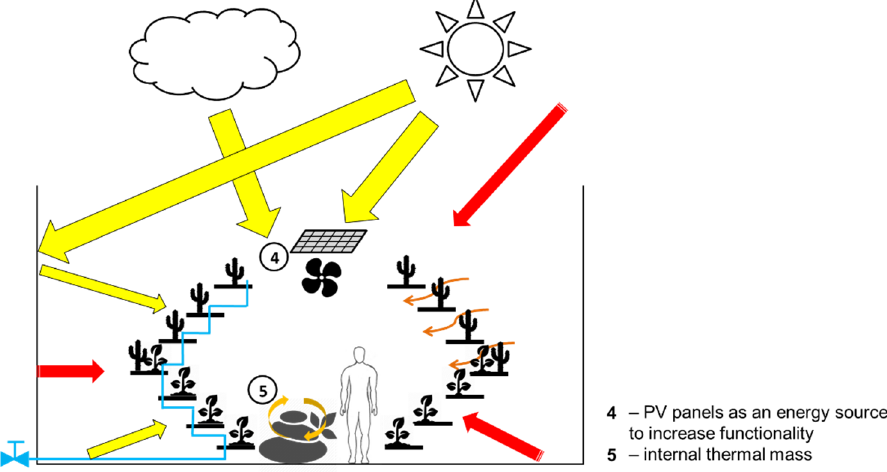
Figure 10. The concept of the GS—possibilities for the further improvement of the concept.